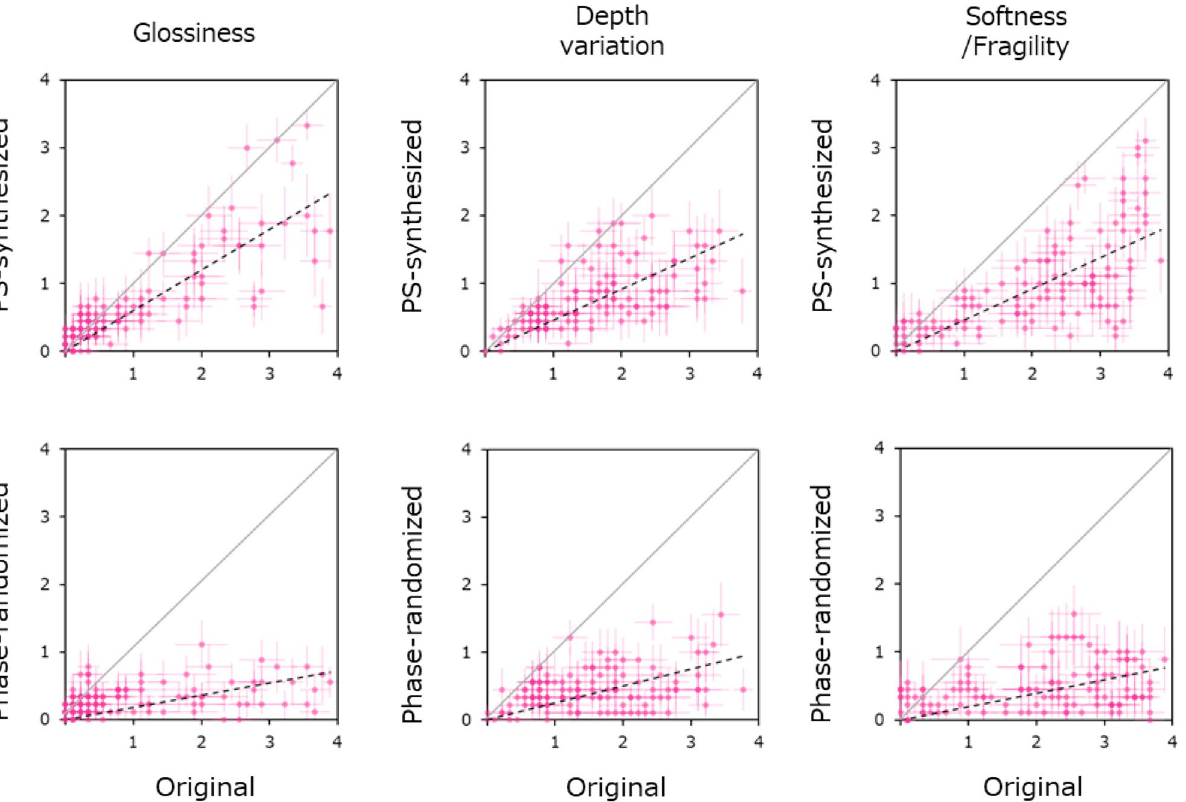
Figure 7. Surface properties ratings for the original and the synthetic images. Each panel shows the relationship between the ratings obtained for the original and the synthetic image. The left, middle, and right columns show the results for glossiness, depth variation, and softness, respectively. The upper panel shows the relationship between the original image and the PS-synthesized image, and the lower panel shows the relationship between the original image and the phase-randomized image. Error bars indicate the ± 1 s.e.m. across